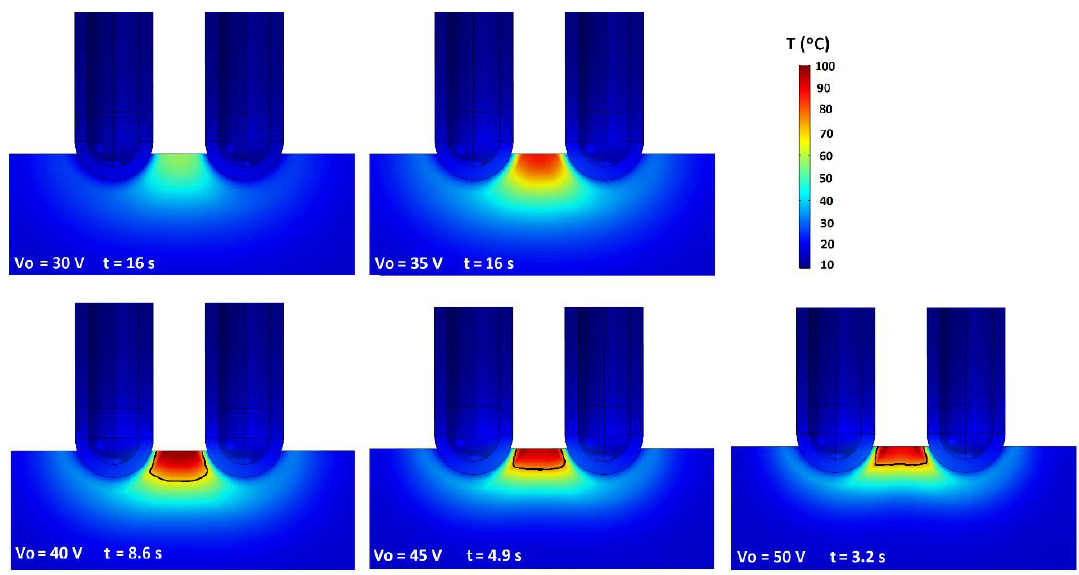
Figure 6. Temperature distribution (°C) and isosurface Ω = 1 (black line) for SMM in the symmetry plane of the geometry representing cases of V 0 = 40 (t = 16 s), 45 (t = 14 s), 50 (t = 8.88 s), 55 (t = 5.77 s),